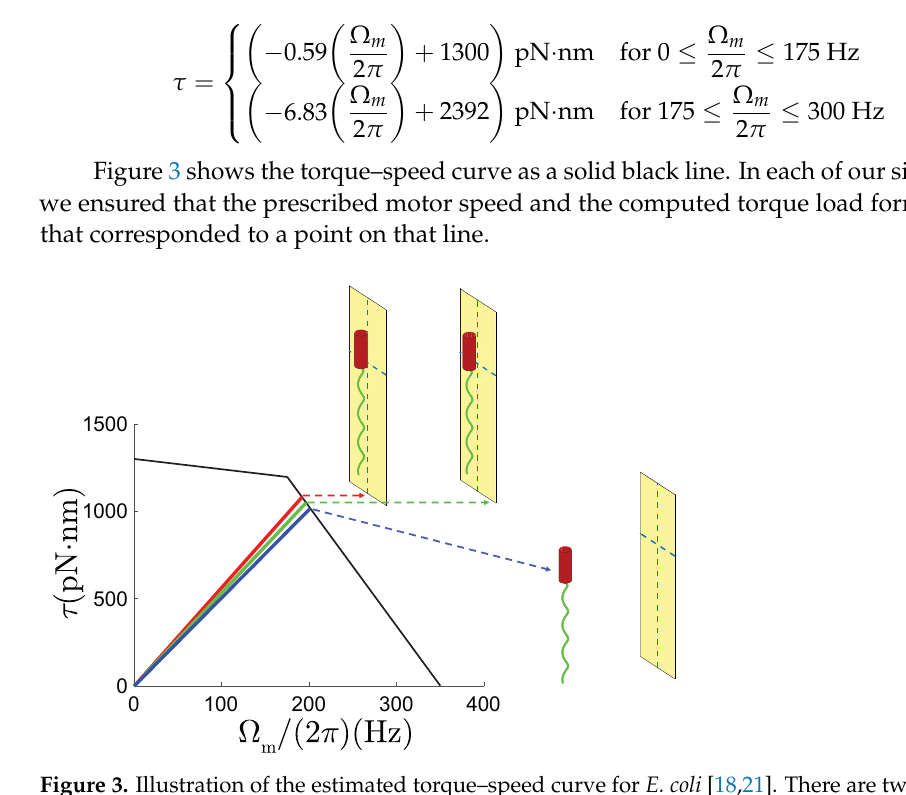
Figure 3. Illustration of the estimated torque–speed curve for E. coli [18,21]. There are two operating regimes: a relatively flat low-speed regime 0 ≤ Ω m /2 π ≤ 175 Hz where the torque drops from its maximum value of 1300 pN · nm at 0 Hz to 1196 pN · nm at 175 Hz and a relatively steep high-speed regime 175 ≤ Ω m /2 π ≤ 350 Hz where the torque drops from 1196 pN · nm at 175 Hz to 0 pN · nm at 350 Hz. The insets depict a bacterium model with the average body length (cid:96) = 2.5 µ m, the smallest body radius r = 0.395 µ m, and the average flagellar wavelength λ = 2.22 µ m at different distances from the boundary: d = 8.2 µ m (blue), d = 0.71 µ m (green), d = 0.54 µ m (red). At closer distances, the torque versus rotation rate load lines are steeper so that they intersect the torque–speed curve at a slower rotation